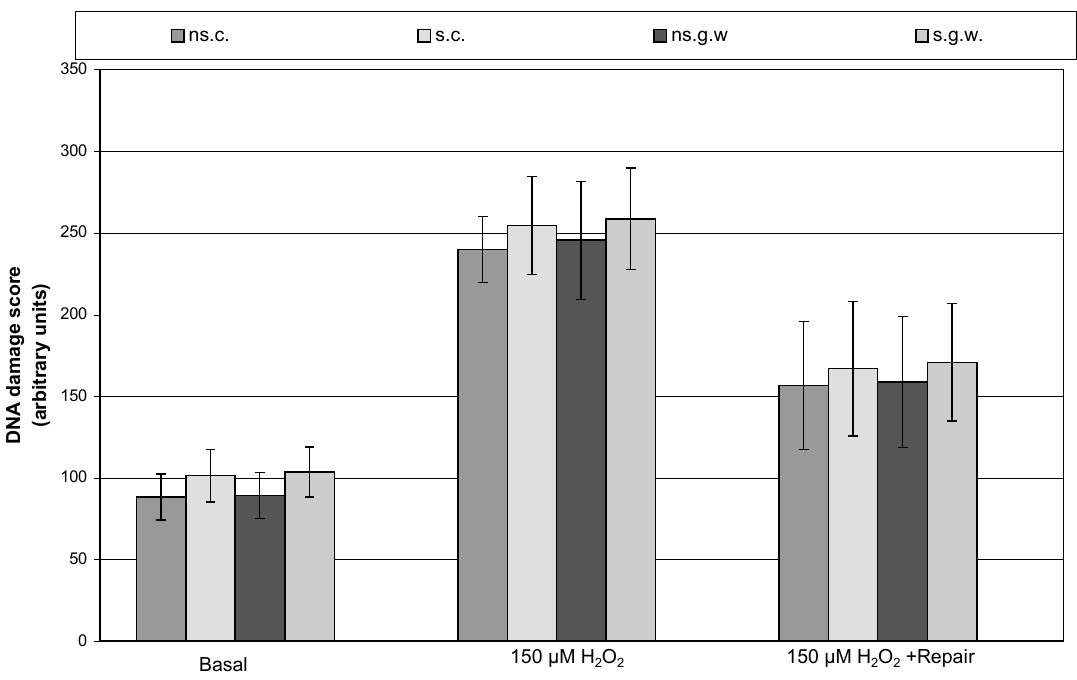
FIGURE 1. Response of lymphocytes of the groups [nonsmokers control (ns.c); smokers control (s.c.); nonsmokers greenhouse workers (ns.g.w.); smokers greenhouse workers (s.g.w.)] after exposure to 150 μ M H 2 O 2 and after repair. Error bars represent the standard deviation of the mean among the